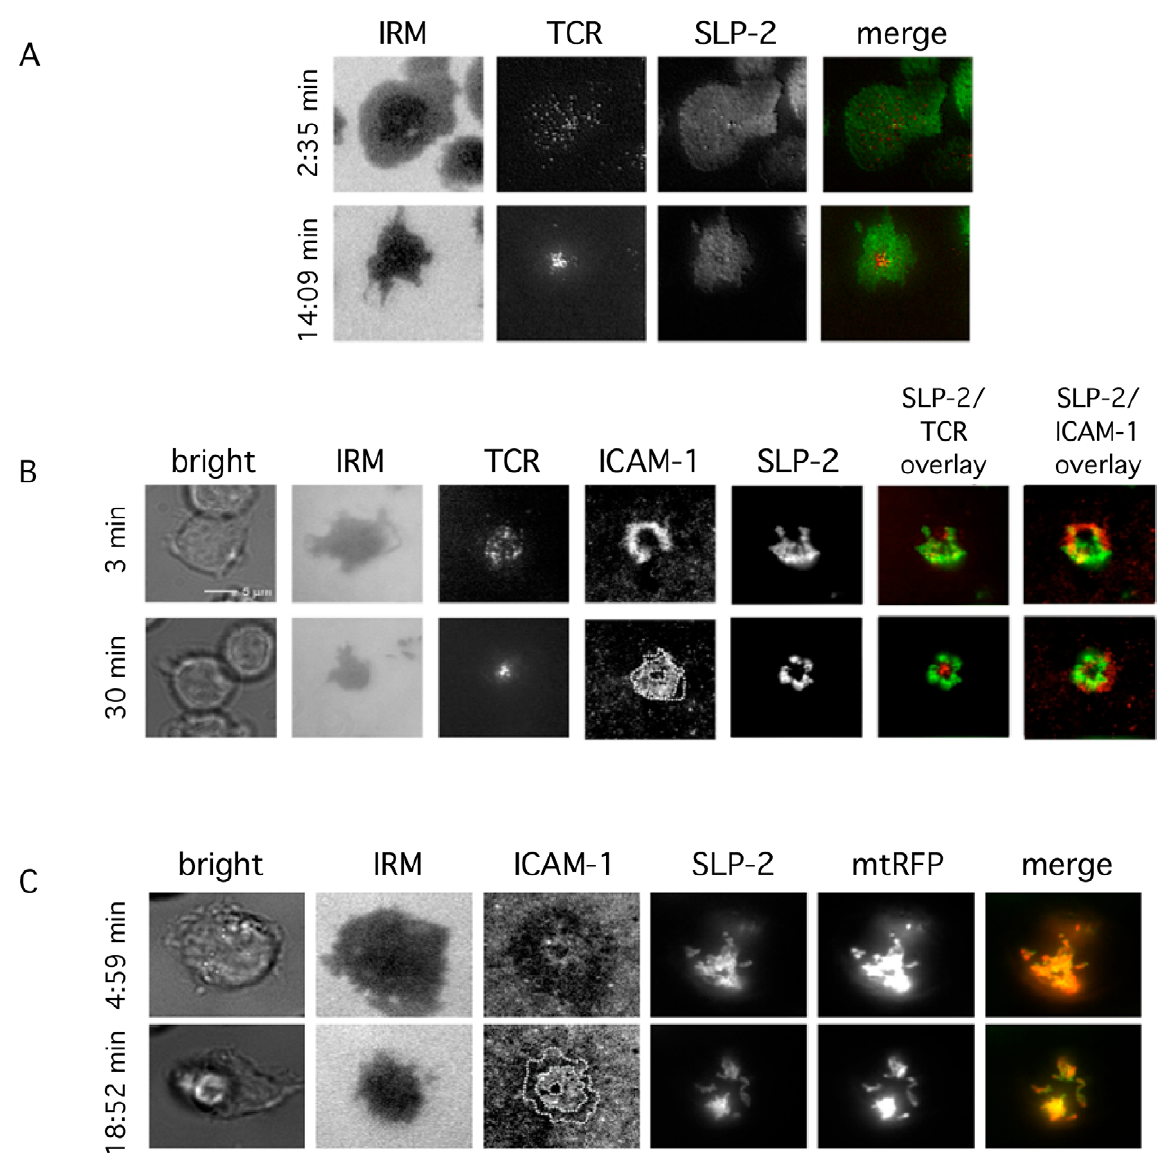
Figure 5. Redistribution of plasma membrane-associated SLP-2 and mitochondria-associated SLP-2 during immunological synapse formation. Jurkat T cells stably expressing SLP-2-gfp were incubated on planar membranes containing ICAM-1 and anti-CD3 to induce immunosynapse formation. Cells were imaged at early ( , 5 min) and late (15–30 min) stages of immunosynapse formation to demonstrate SLP-2 redistribution upon TCR ligation. A) Plasma membrane-associated SLP-2 redistribution during immunosynapse formation was imaged by TIRFM, to eliminate signal from the mitochondrial pool of SLP-2. Cell contact with the planar membrane was imaged by IRM, TCR images were obtained by wide-field fluorescence microscopy and the image overlay represents SLP-2-gfp as green and TCR as red. B) Total SLP-2-gfp, including both plasma membrane-associated and mitochondrial pools was imaged at early and late stages of immunosynapse formation. The bright field image shows cells being imaged, IRM images show contact with the bilayer as dark areas, and the TCR, ICAM-1 and SLP-2-gfp fluorescence channels are shown in gray scale and two red-green merges (green is always SLP-2). The dotted lines in the ICAM-1 picture represent, from the periphery to the centre of the picture, the outer boundaries of the distal SMAC, of the pSMAC, and of the cSMAC. Images are representative 3 separate experiments. C) SLP-2-gfp expressing Jurkat cells were transfected with mitochondria-targeted RFP to verify mitochondrial localization of intracellular SLP-2-gfp. Images were obtained by wide-field fluorescence microscopy and are representative of three separate experiments. The dotted lines in the ICAM-1 image are as described in B. The percentage of cells showing segregation of the mitochondrial pool of SLP-2 away from the cSMAC is shown in table 1 and this organization of SLP-2 into the pSMAC requires anti-CD3 ligation (table